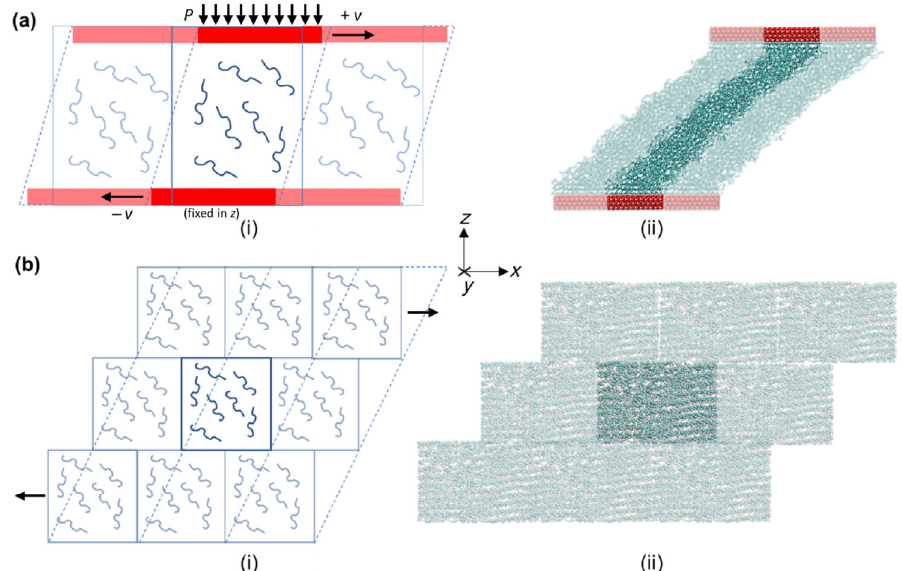
Fig. 1 (a) Confined NEMD schematic (i) and an example image from an NEMD simulation adapted from Ref. [29] (ii). (b) Bulk NEMD schematic using Lees-Edwards PBC (i) and an example image from an NEMD simulation (ii). Translucent regions show the periodic image of the simulation cell from the PBCs